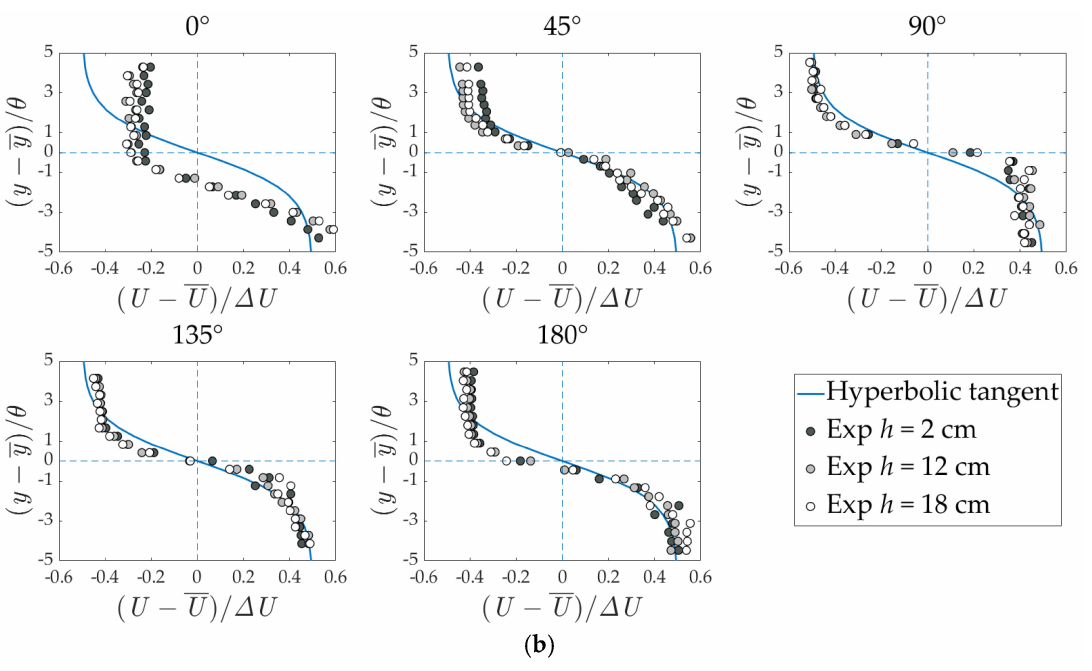
Figure 4. Fitting of transverse velocity distribution for different vegetation distribution. ( a ) Convex case. ( b ) Concave case.